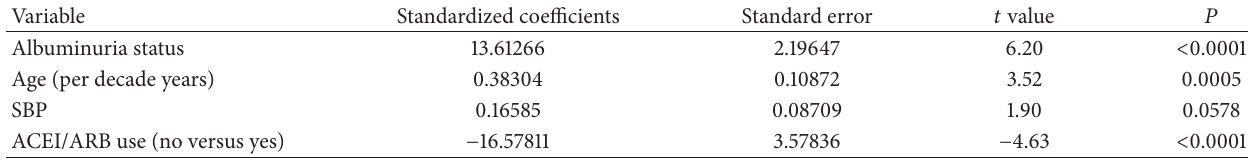
Table 3: The stepwise multiple linear regression for LVMI in patients with type 2 diabetes.